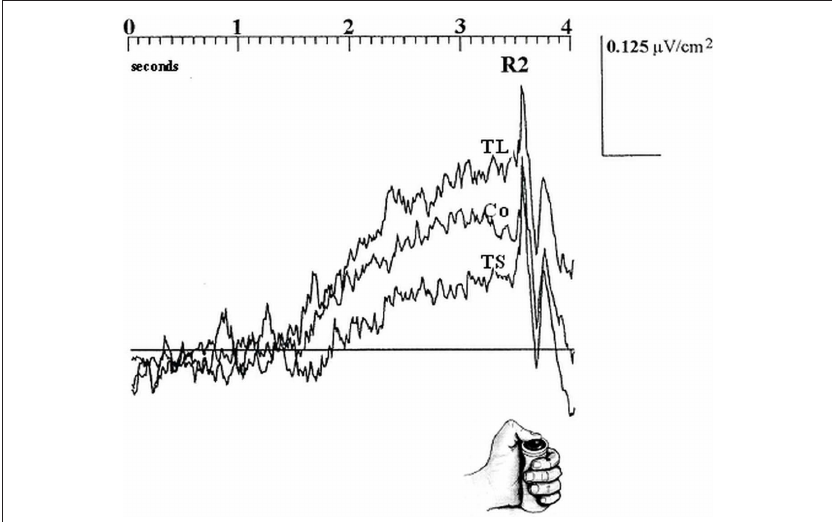
Figure 1 | electrophysiological activity over the SMAs in 10 subjects during a time production task as a function of performance (TL, “too long”; Co, “correct”; TS, “too short”) time-locked to the end (button press) of the interval. Amplitude (negative up) on ordinates, time on abscissas. Adapted from Macar et al.,